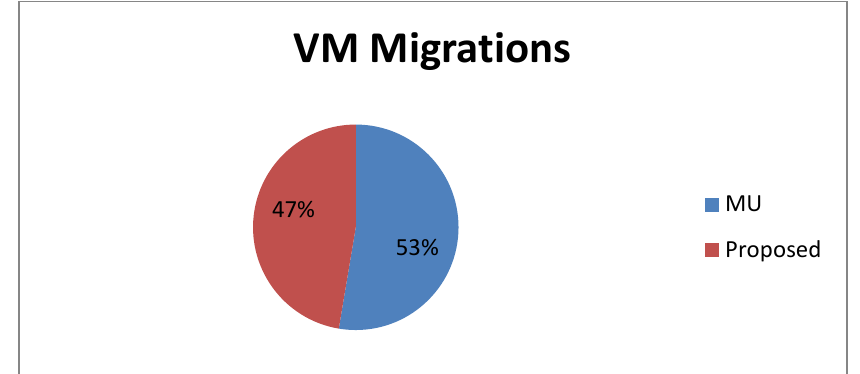
Figure1. Surface of errors of Sugeno type fuzzy systems Fig. 1. The number of VM (Virtual Machine) migration and host